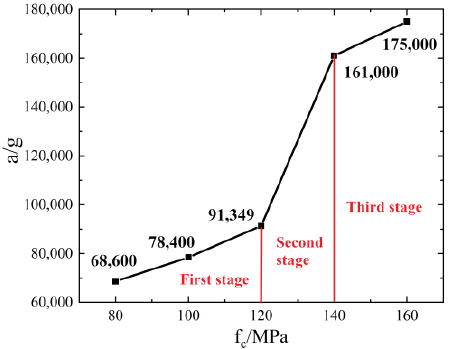
Figure 16. Relation between penetration acceleration and target strength change.